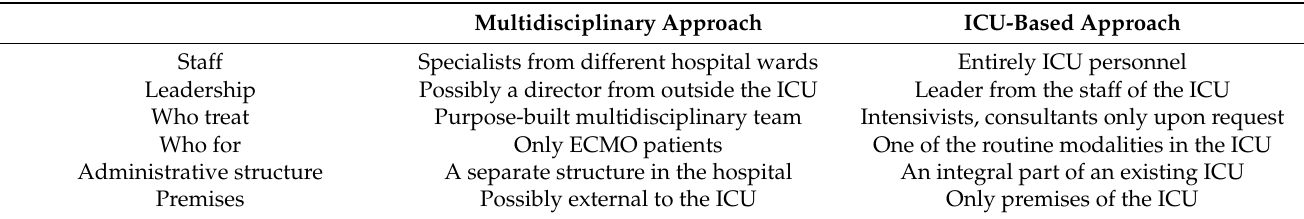
Table 4. Methods for organizing the ECMO